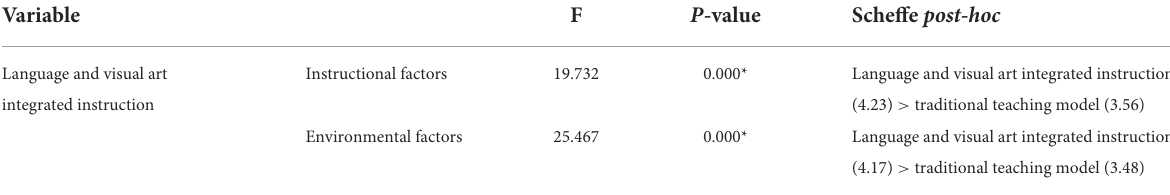
TABLE 2 Variance analysis of language and visual art integrated instruction in language learning performance. Variable F P